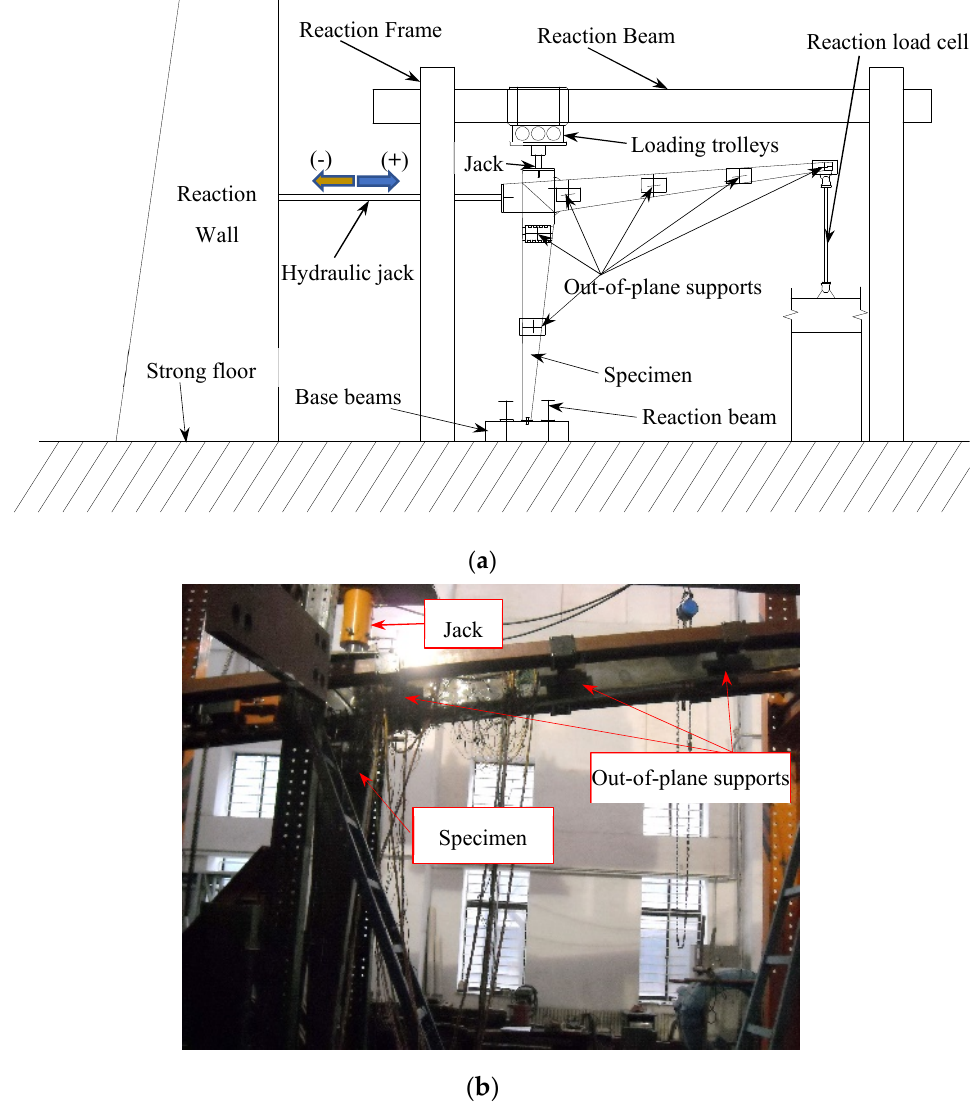
Figure 4. Test setup. ( a ) Diagram; ( b ) Photo.